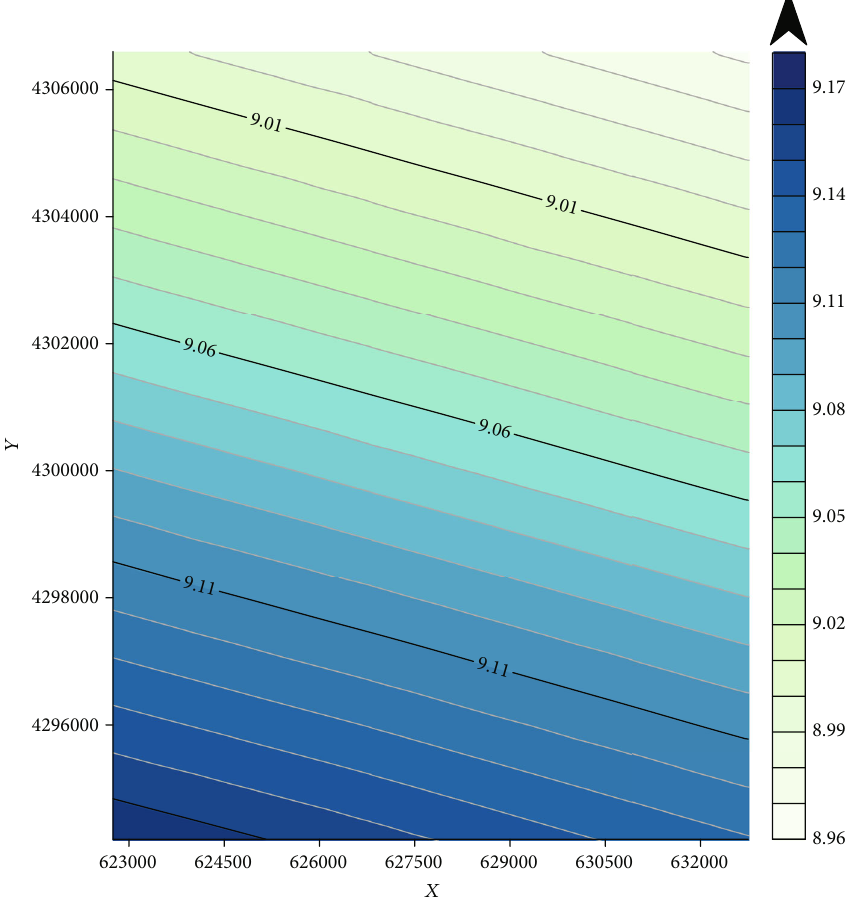
Figure 2: Velocity distribution isogram along the eastern direction within the well fi eld